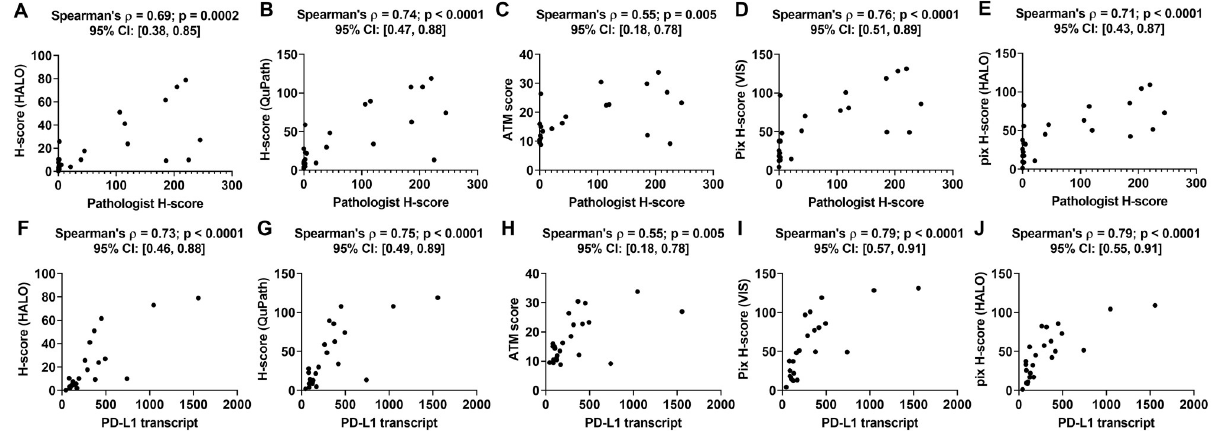
Fig 4. Performance of DIA endpoints obtained from PD-L1 IHC images. Panels A-E show plots of the different DIA endpoints as a function of the pathologist H-score, while panels F-J show the same as a function of PD-L1 mRNA transcript for a cohort of 24 lung cancer resections. All panels show the Spearman’s correlation coefficient between the two quantities plotted in that panel along with the p-value and the 95% confidence interval.